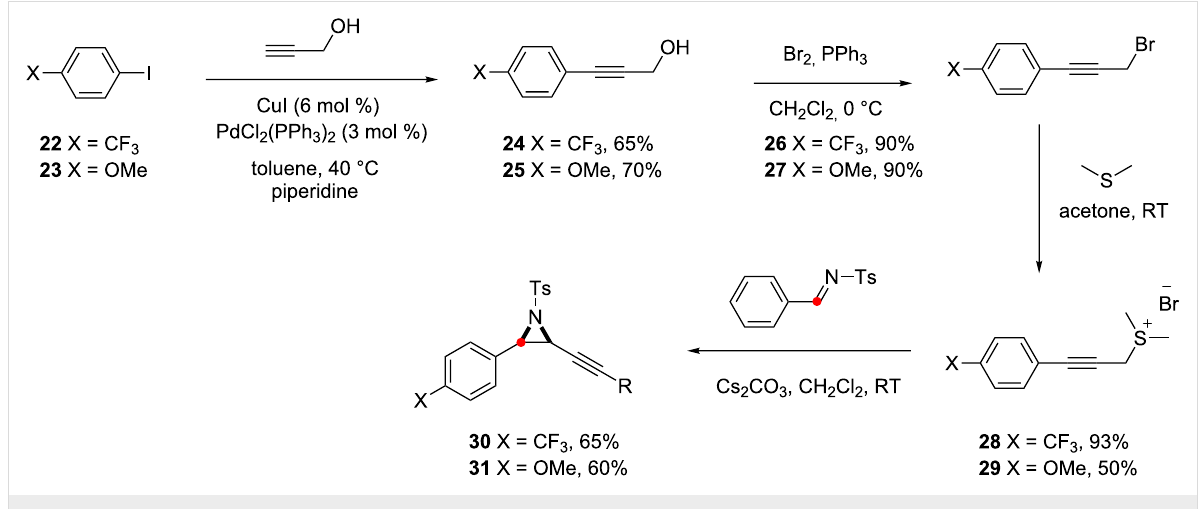
Scheme 12: Synthesis of alkynyl aziridines 30 and 31 .